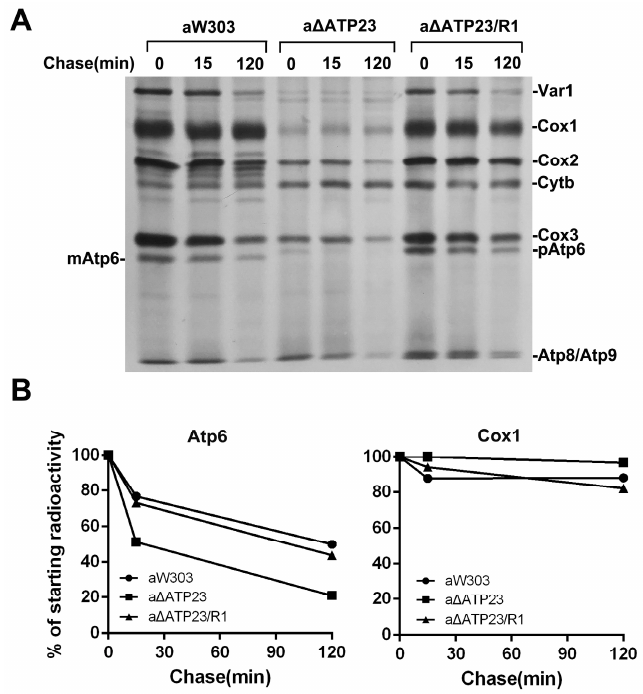
Figure 5. Increased stability of Atp6 in revertants. ( A ) Chasing stability of newly synthesized Atp6 by chasing labeling. Wild-type aW303, atp23 null mutant a ∆ ATP23, and atp23 revertant a ∆ ATP23/R1, were grown in YPGal and labeled in vivo for 20 min with [ 35 S]-methionine in the presence of cycloheximide. Excess cold methionine was added to stop labeling, and samples were taken after the indicated time at 30 °C. ( B ) Quantification of the radioactivity of Atp6 and Cox1. The bands corresponding to Atp6 or Cox1 were quantified with a Phosphor Imager and normalized to value obtained at time zero.